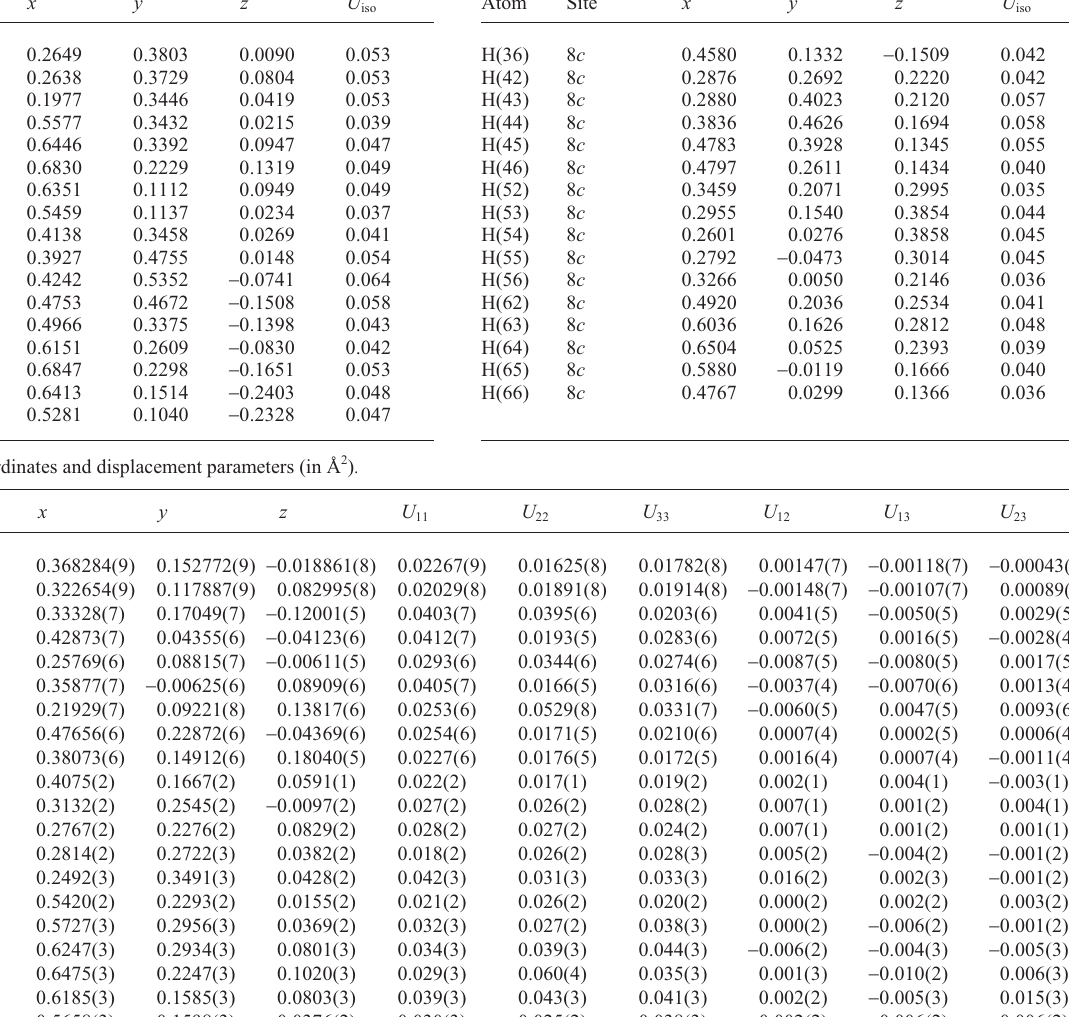
Table 2. Atomic coordinates and displacement parameters (in Å 2 ) . Atom